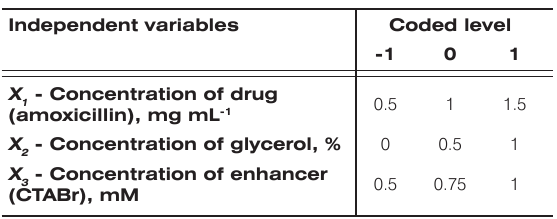
Table 2. Box–Behnken experimental design and response